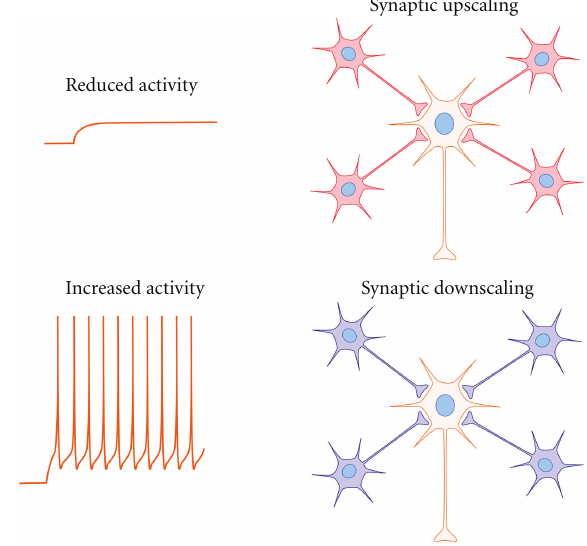
Figure 2: Synaptic scaling. Synaptic scaling involves global adjust- ments of all synapses in a neuron in response to global changes in neuronal activity. Decreases in neuronal activity lead to global increases in synaptic e ffi cacy in the target neuron (upscaling). Increases in neuronal activity lead to global decreases in synaptic e ffi cacy in the target neuron (downscaling). This form of plasticity is considered “non-Hebbian” because it involves global adjustments of synapses, rather than input-specific changes in discrete